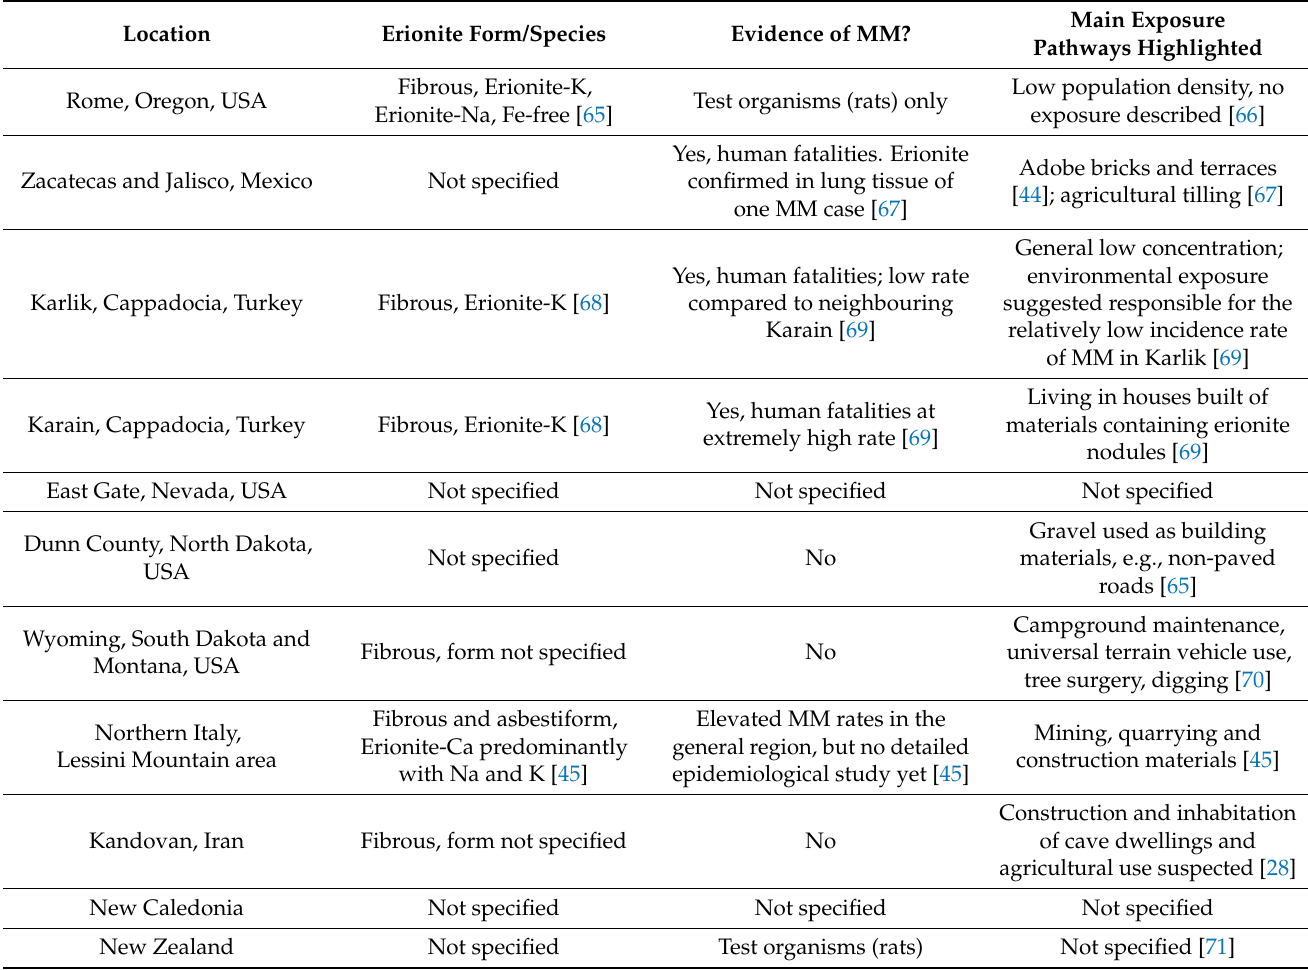
Table 1. Summary of observed erionite exposure pathways and their link to evidence of MM (form and habit identified where